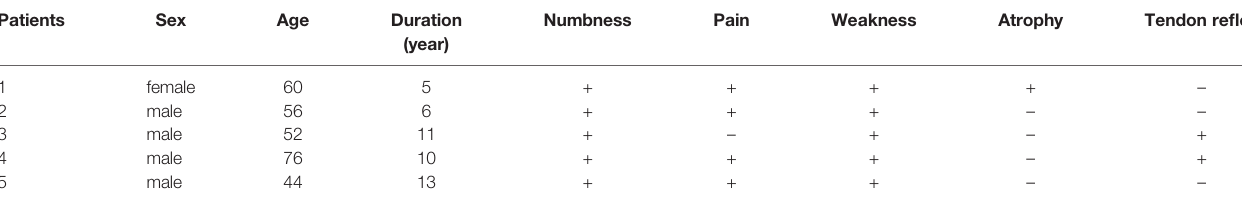
TABLE 6 | General characteristics and clinical signs of the patients (n = 5). Patients